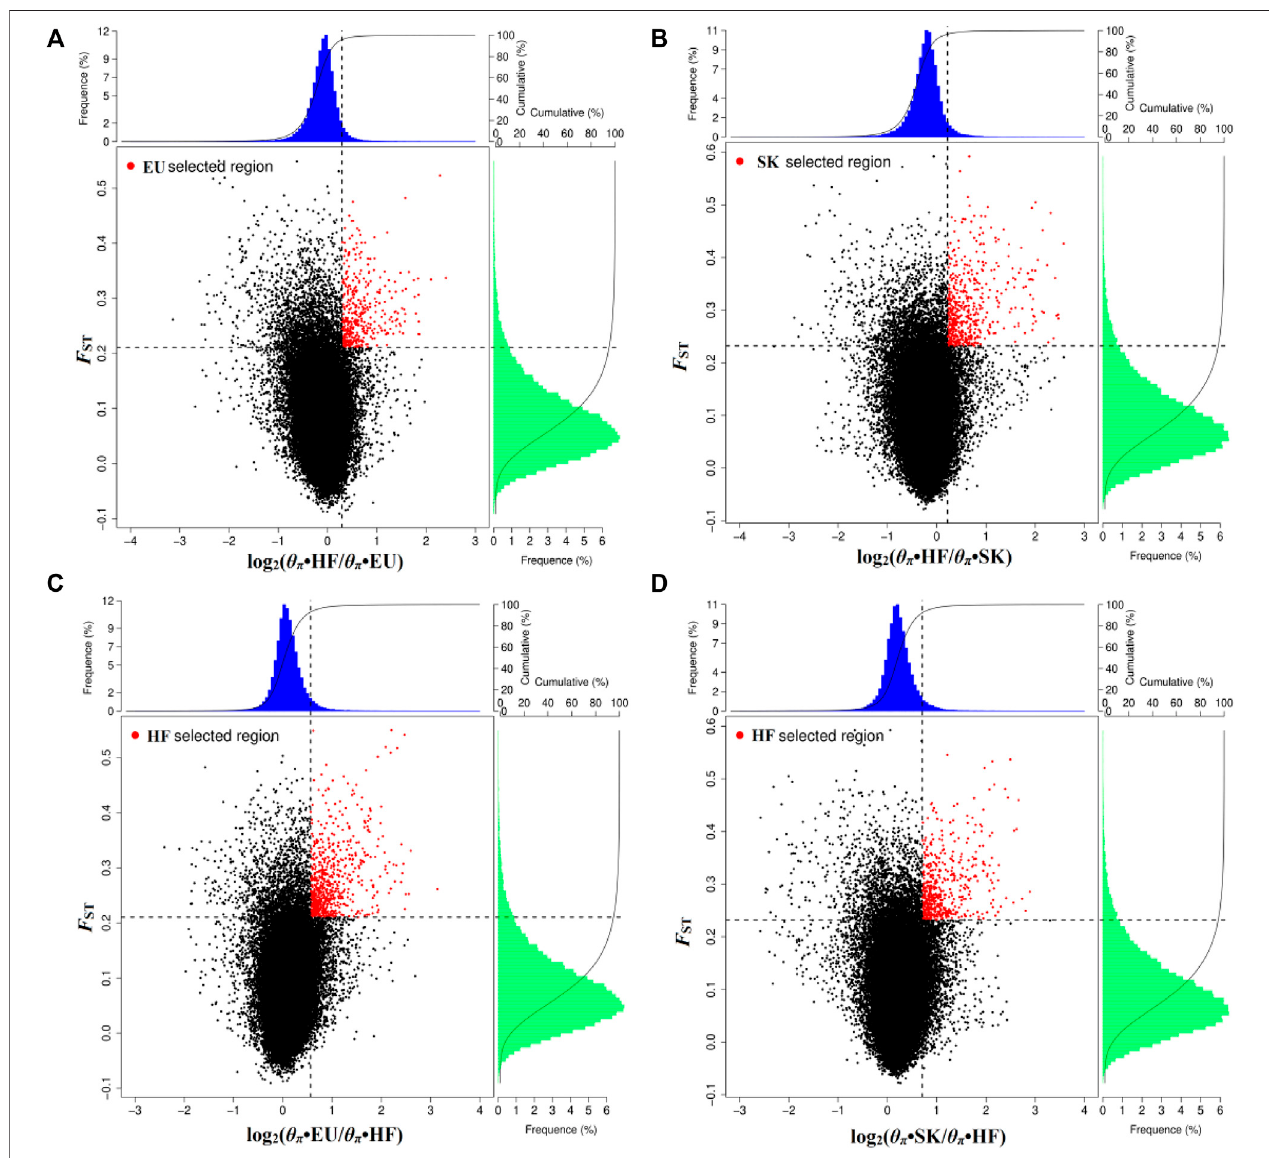
(cid:129) (cid:129) FIGURE 2 | Distribution of log 2 values ( θ π control/ θ π selected) and the top 5% highest F ST values calculated in 40-kb sliding windows with 20-kb increments. (A) Compared with HF, EU are subject to positive selection of genomic regions. (B) Compared with HF, SK are subject to positive selection of genomic regions. (C) Compared with EU, HF are subject to positive selection of genomic regions. (D) Compared with SK, HF are subject to positive selection of genomic regions.